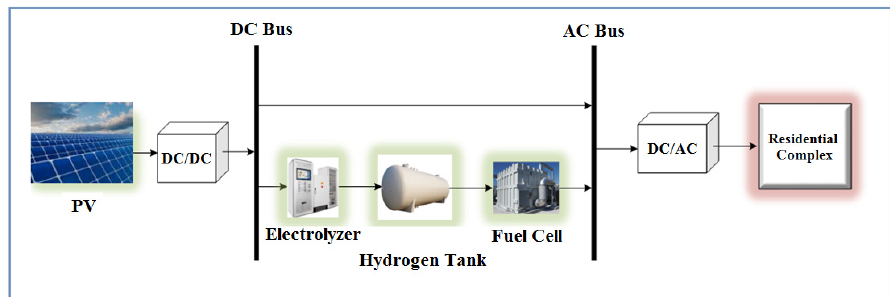
Figure 1. Schematic of HPV/FC energy system.